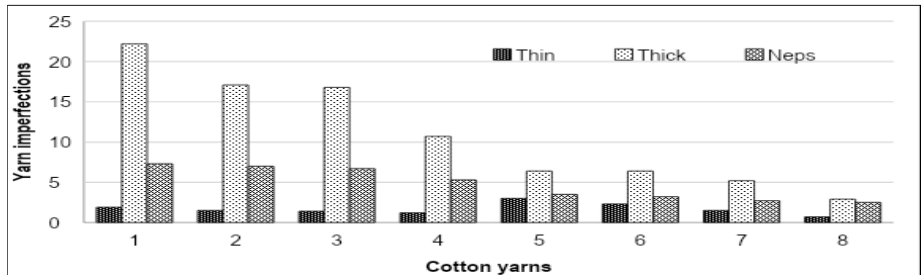
Fig. 6: Impact of twist on yarns thin and thick places, and neps Table 4 Measured and calculated values of yarn